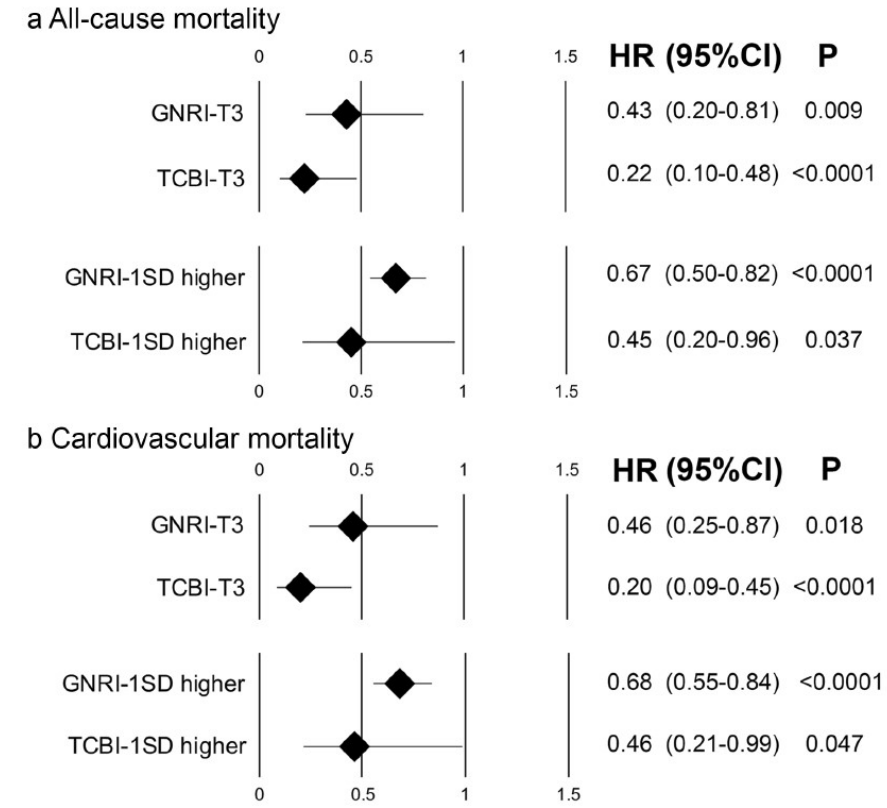
Figure 3. Adjusted hazard ratios for all-cause and cardiovascular mortalities of higher TCBI. Forest plots of higher GNRI and TCBI as a nominal variable (highest tertile, T3, upper panel) and continuous variable (1 standard deviation (SD) higher, lower panel) for all-cause (a) and cardiovascular (b) mortality. CI: confidence interval, P: p -value.